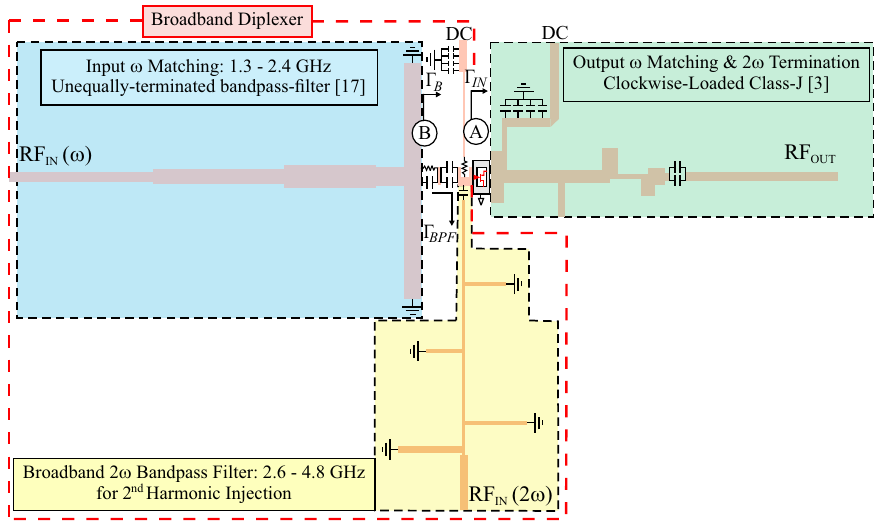
Figure 4. Input and output circuit schematic of the broadband clockwise-loaded class-J (CLCJ)